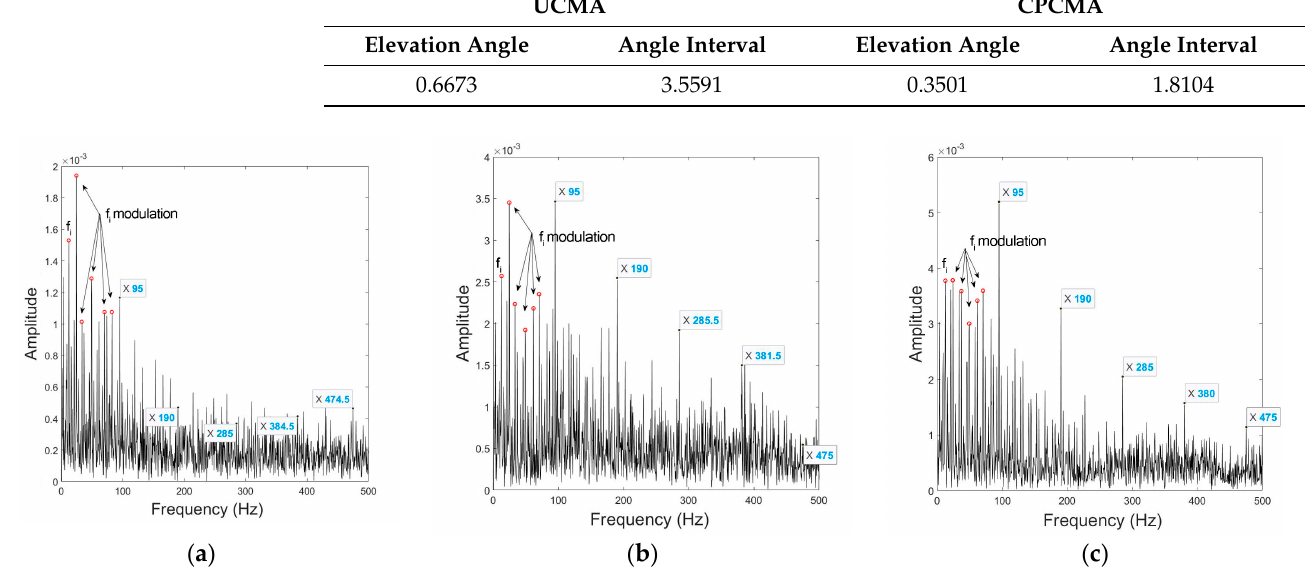
Figure 12. Envelopes under inner race fault condition at 725 rpm of: ( a ) non − processed mono signal; ( b ) UCMA − ESPRIT beamformed signal; ( c ) CPCMA − ESPRIT beamformed signal.